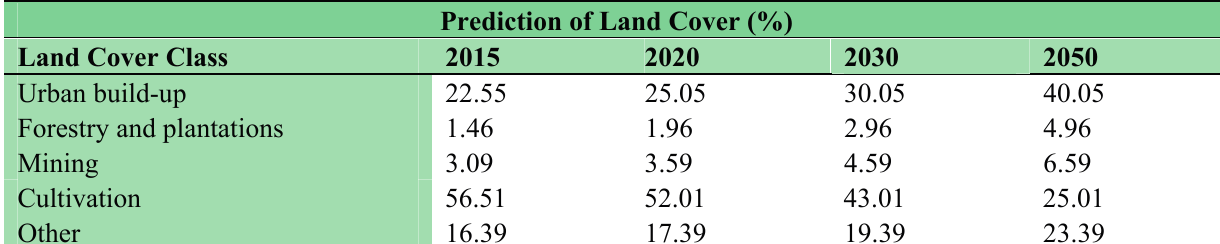
Table 5. Predictions of land cover in the event of a 0.5% per year increase in the extent of urban build-up land cover within the Blesbok Spruit catchment.